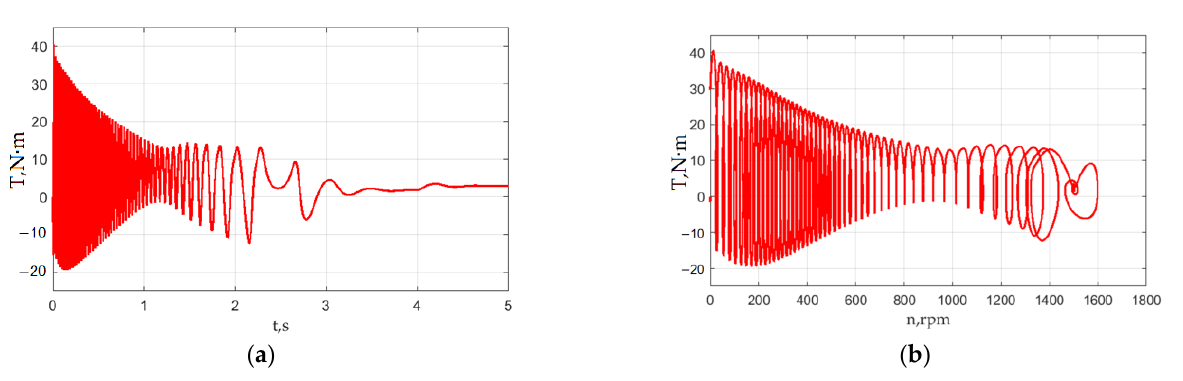
Figure 12. LSPMSM torque with fully closed valve, 380 V: ( a ) Torque versus time; ( b ) torque versus speed.